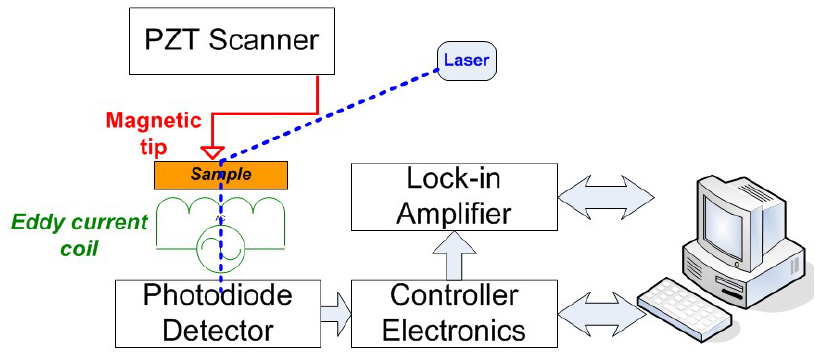
Figure 16. A general schematic of eddy current imaging setup using AFM.